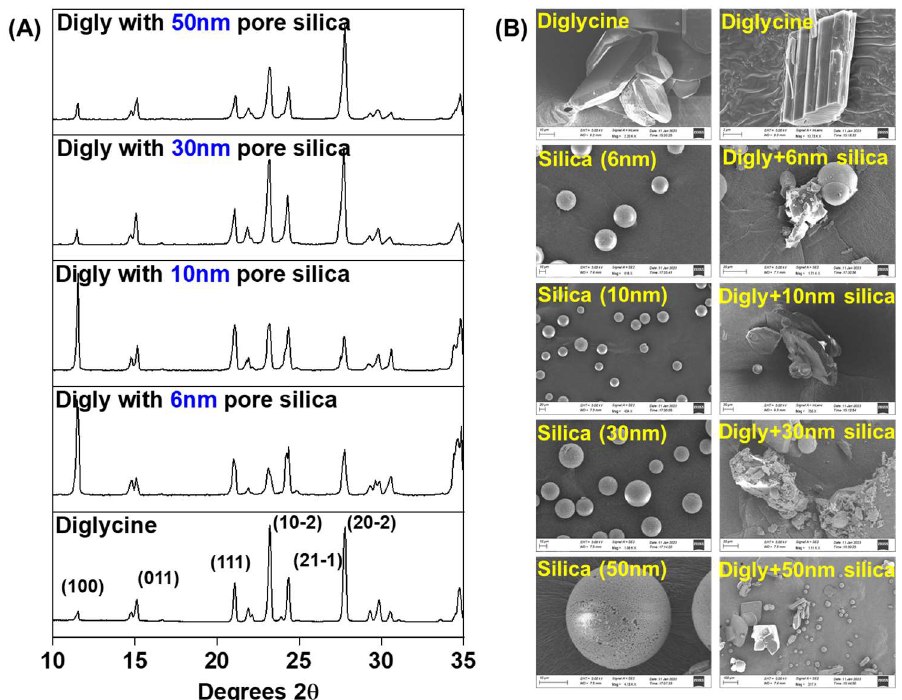
Figure 2. ( A ) Powder X-ray diffraction spectra of the diglycine–silica composite solids isolated upon complete desupersaturation of diglycine in the presence of porous silica at S = 1.20, along with the diglycine patterns; ( B ) Scanning electron microscopy images of diglycine, porous silica, and isolated solids after the desupersaturation experiments in the presence of porous silica.